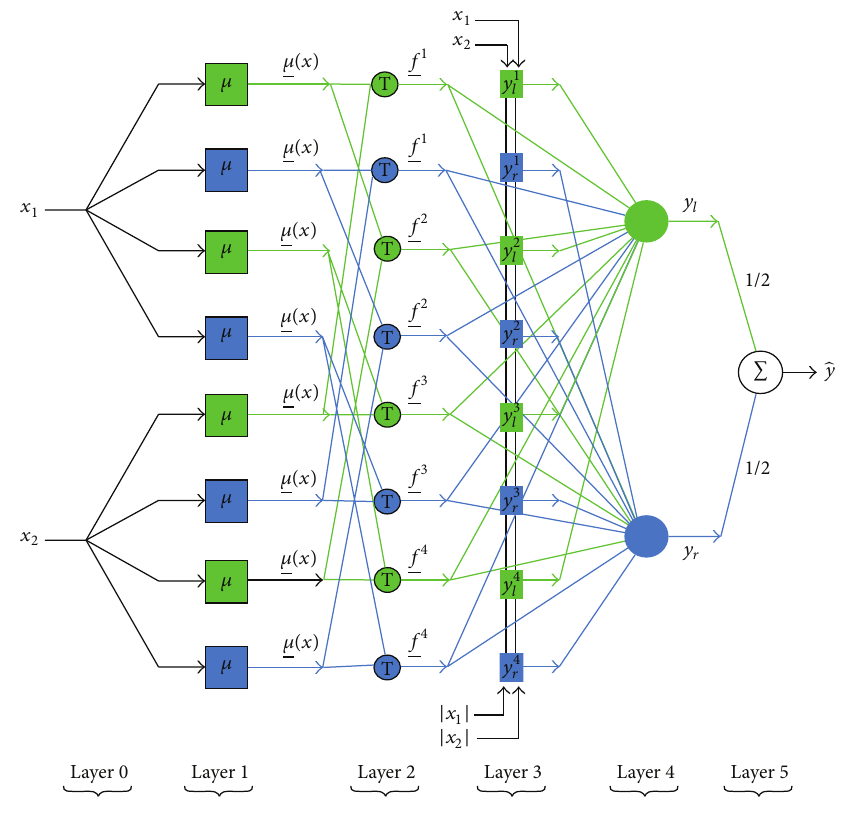
Figure 1: IT2FNN-1